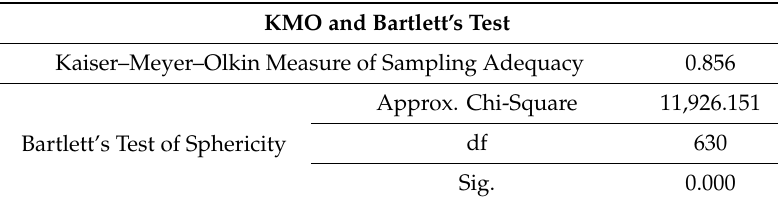
Table 3. Dimension Reduction: Factor